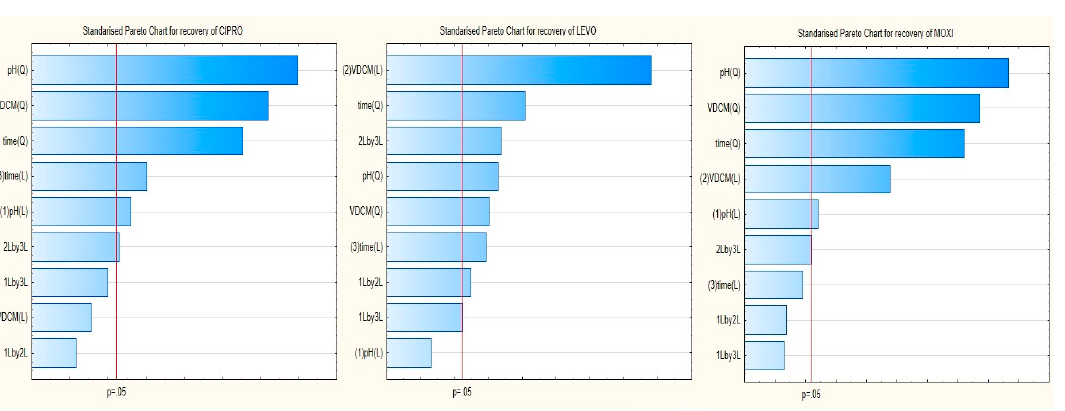
Table 5. The statistical analysis of the applied models.